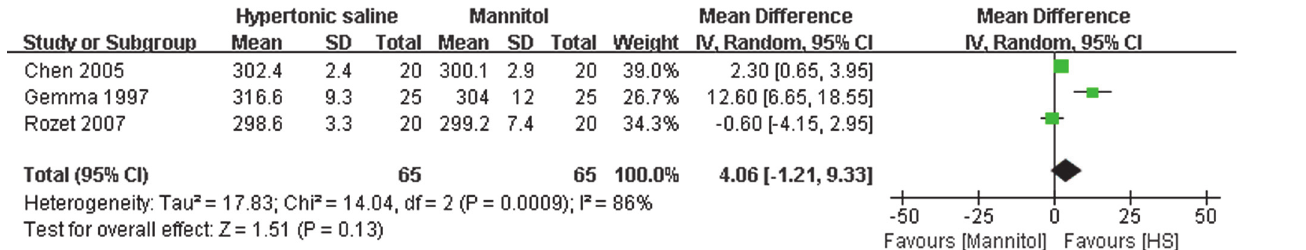
Fig 9. Maximal serum osmolality in HS and mannitol groups. IV: Inverse